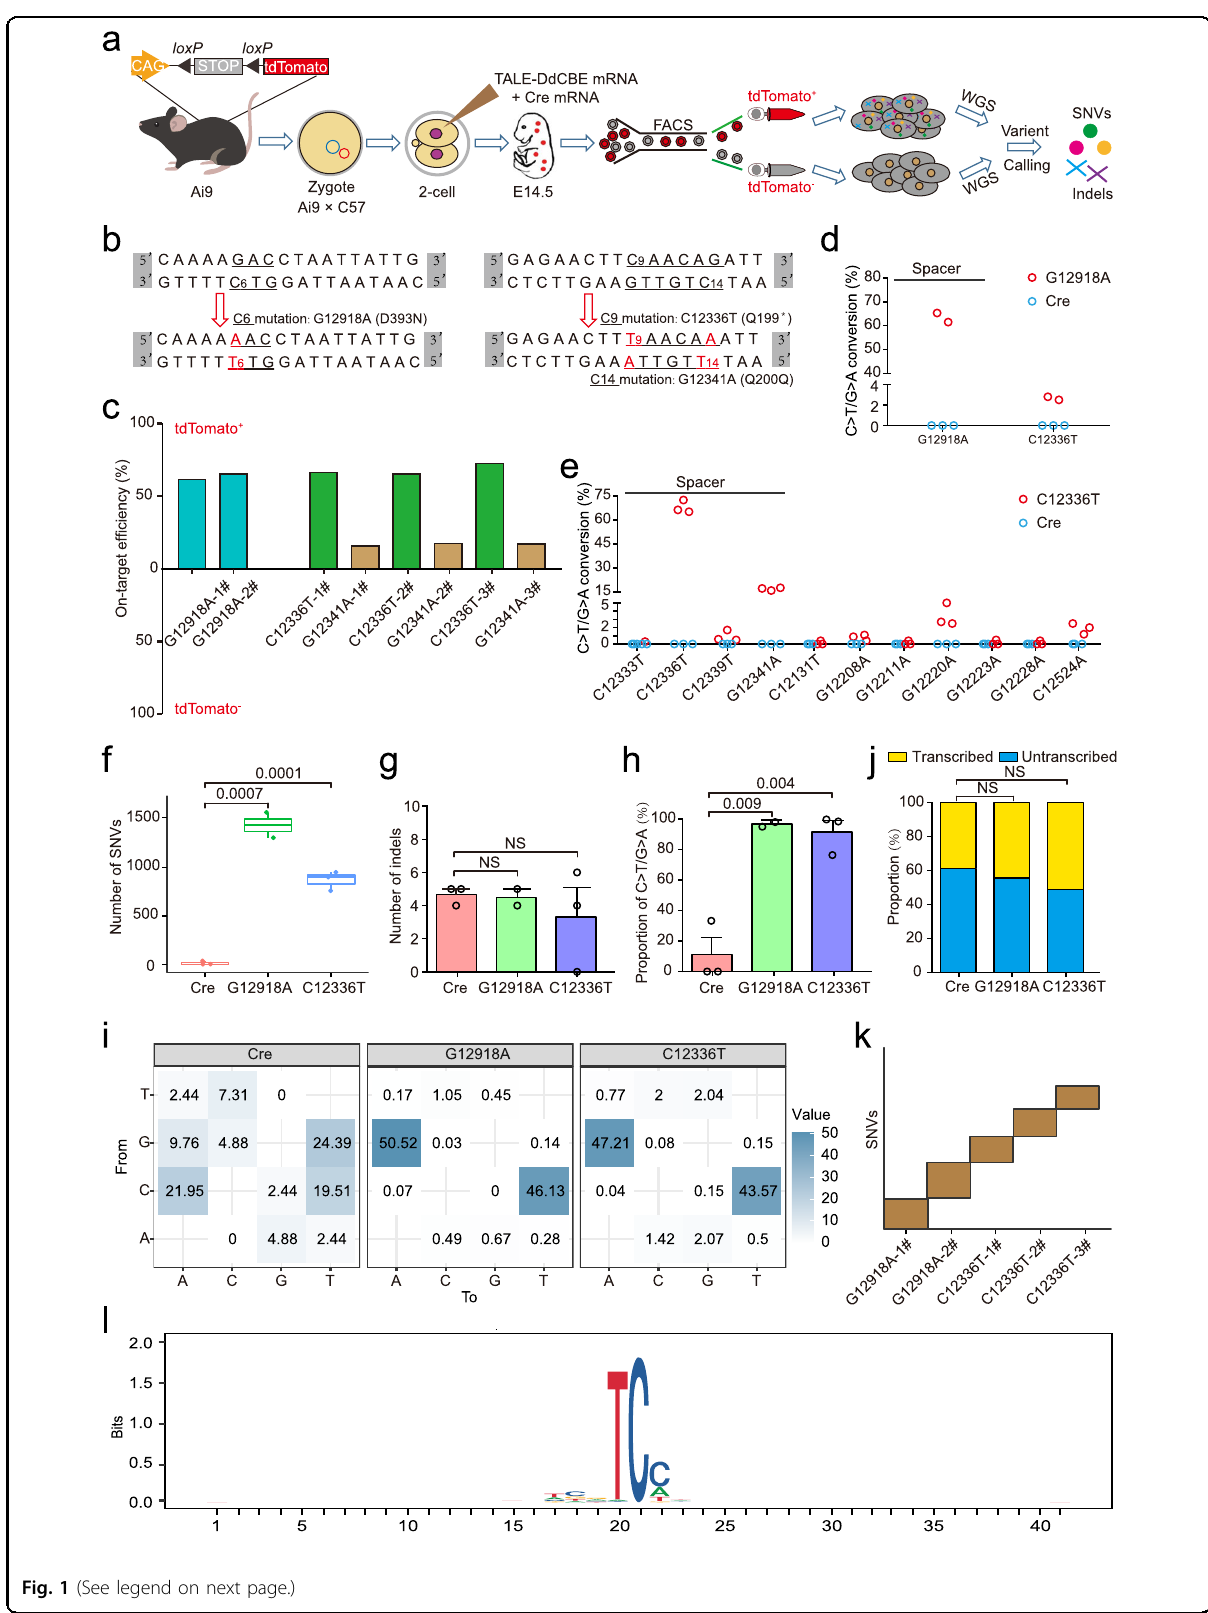
Fig. 1 (See legend on next